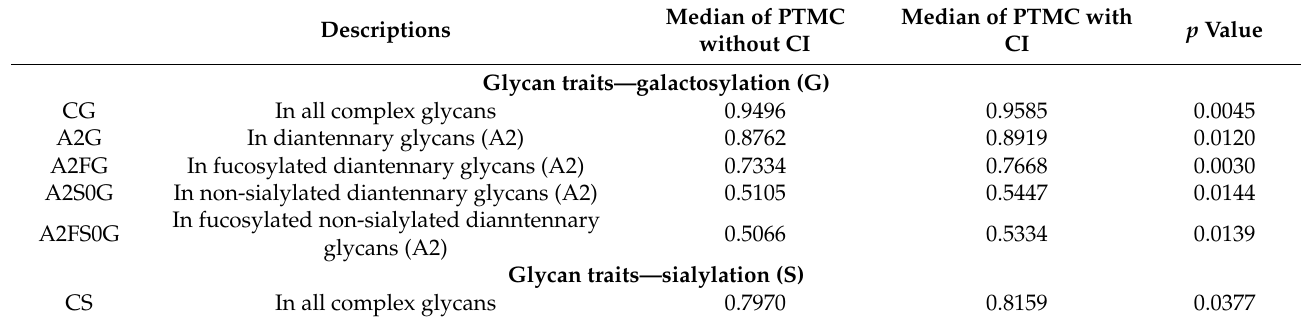
Table 4. The differentially expressed derived N -glycan traits in papillary thyroid microcarcinoma (PTMC) with capsular invasion (CI) compared to PTMC without